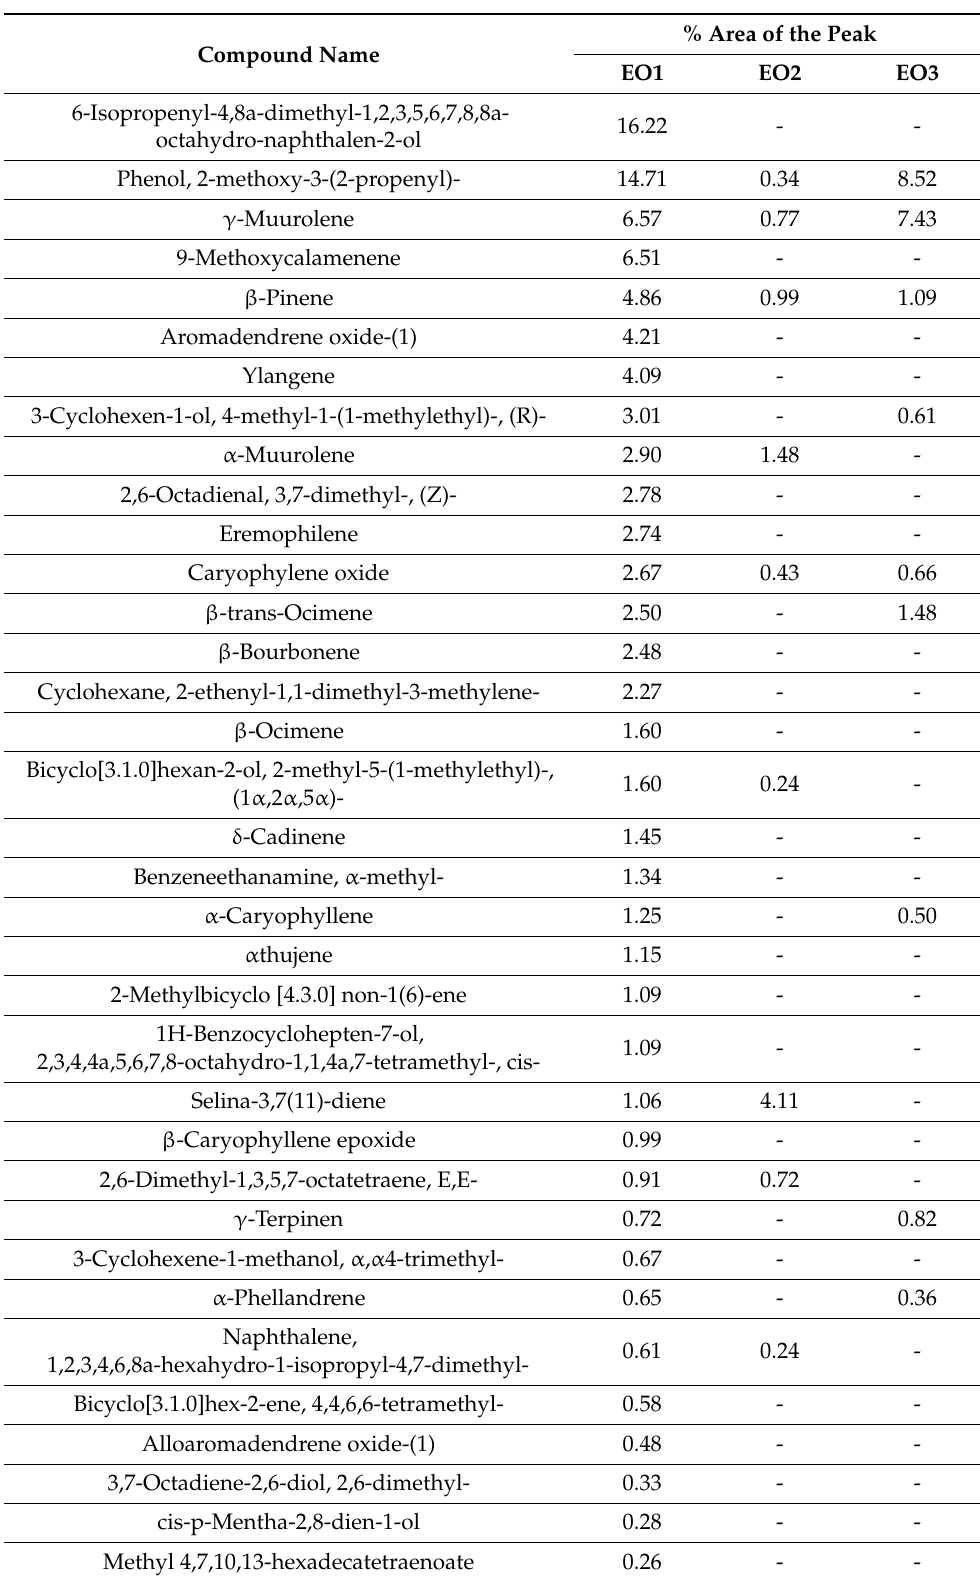
Table 1. GC-MS analysis of essential oil from O. gratissimum (EO1), O. tenuiflorum (EO2), and O. sanctum